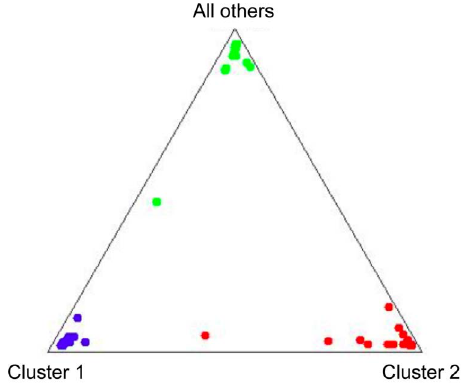
Figure 3. Analysis of microsatellite data. The microsatellite data were analysed with Structure; the most likely number of populations to explain the data was for K=3 ( 2 1525.1). Rough Fell corresponds with cluster 1, Dalesbred with cluster 2 and Herdwick with cluster 3 (all others).